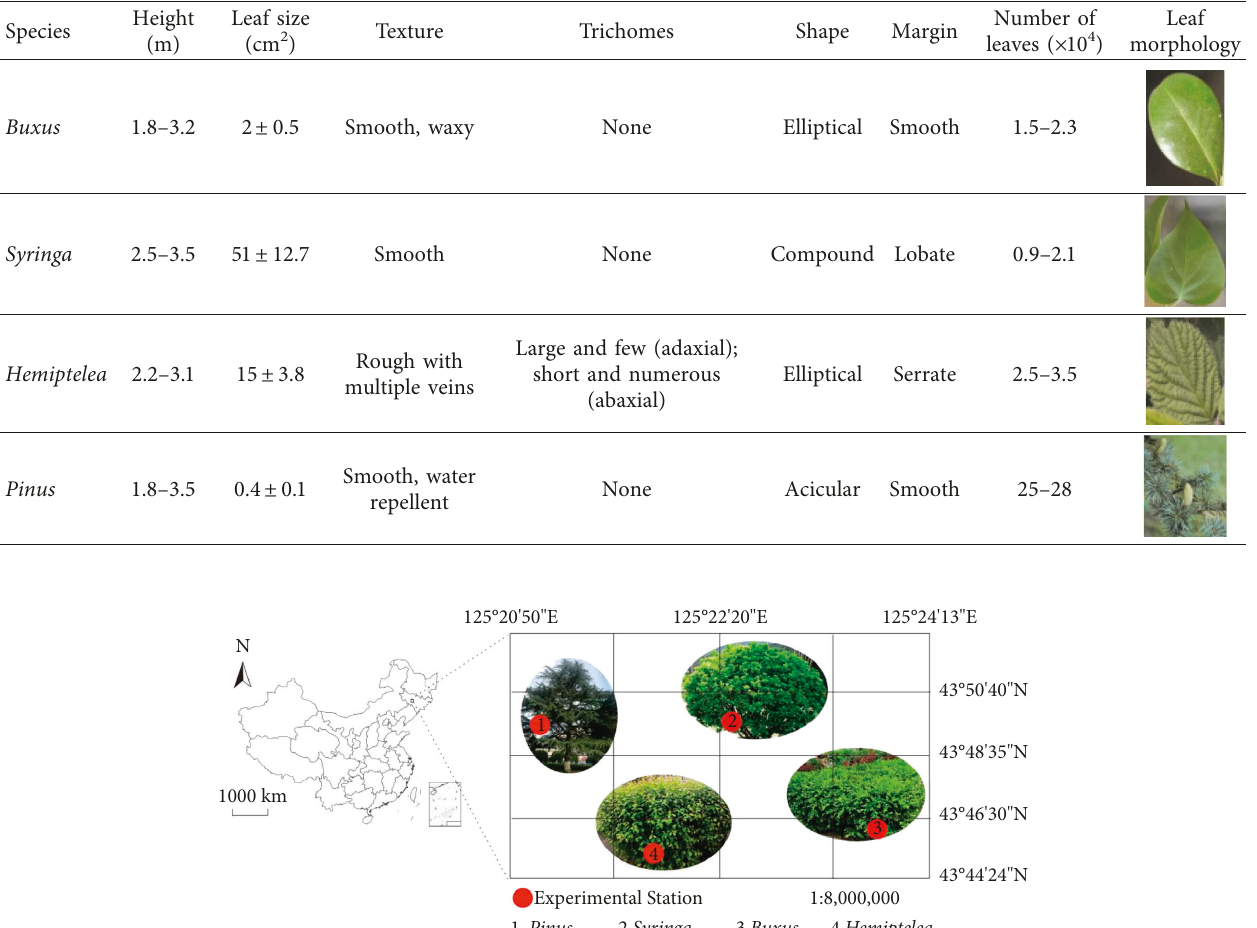
Table 1: Leaf or leaflet traits of the 4 selected plant species.